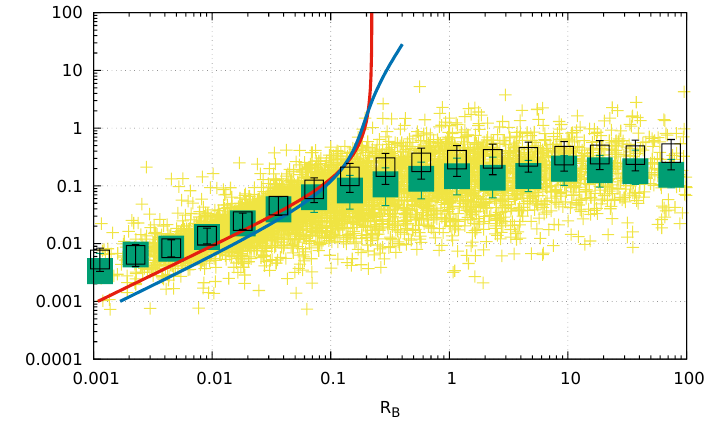
Figure 2. z / L computed using the turbulent fluxes averaged in the 2 ÷ 9 m layer vs. R B . Yel- low: all the 30 min averaged data; green squares with error bars: binned 30 min averaged data, medians and 25–75% percentiles. Black open squares: binned 2 min averaged data. The red line shows the relationship arising from the log-linear non-dimensional profiles, from the integration of Equations (3) and (4). The blue line refers to the profiles by Gryanik et al. ([17], Equations 34 and